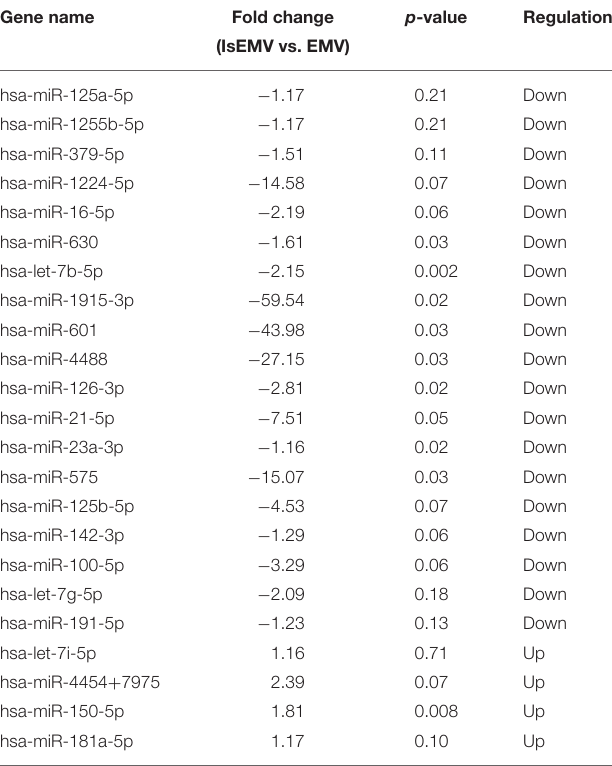
TABLE 1 | Differential expression of screened miRNAs in microvesicles.